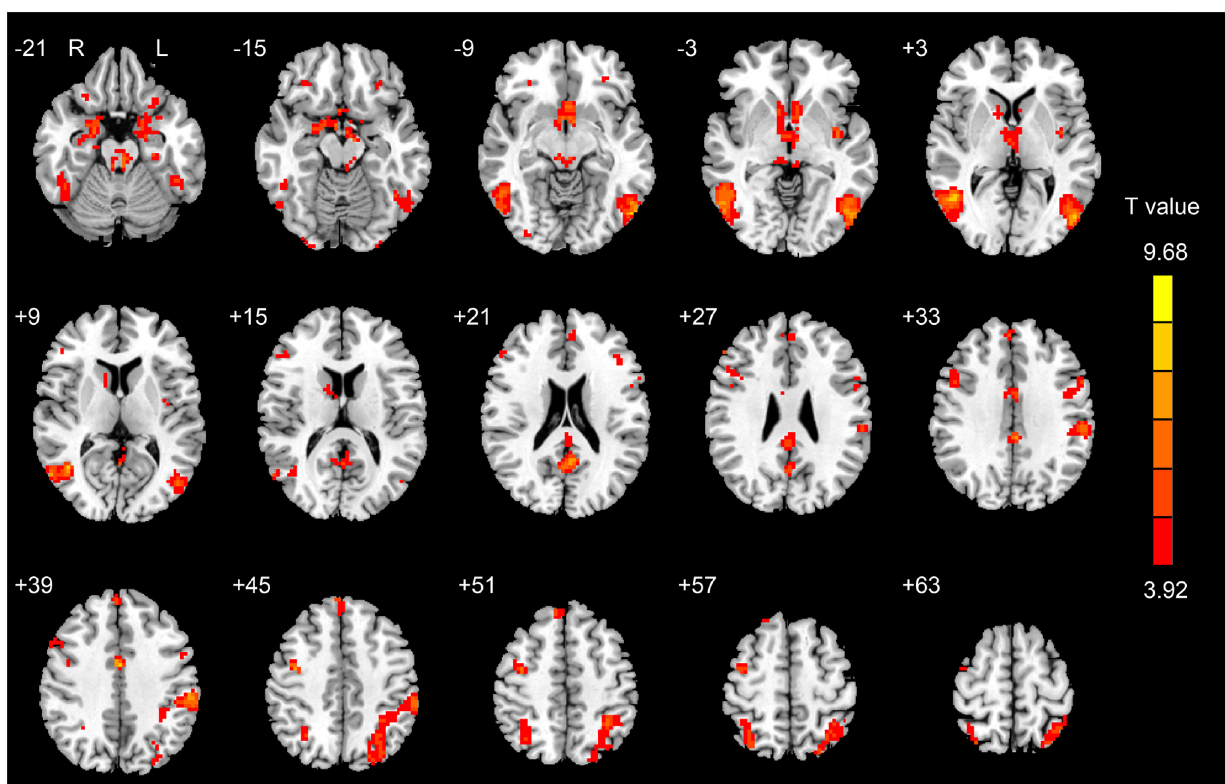
Figure 1. The activated regions relating to the ‘‘Heroin-Neutral’’ contrast for the SA group ( P , 0.05, corrected for Monte Carlo simulations).